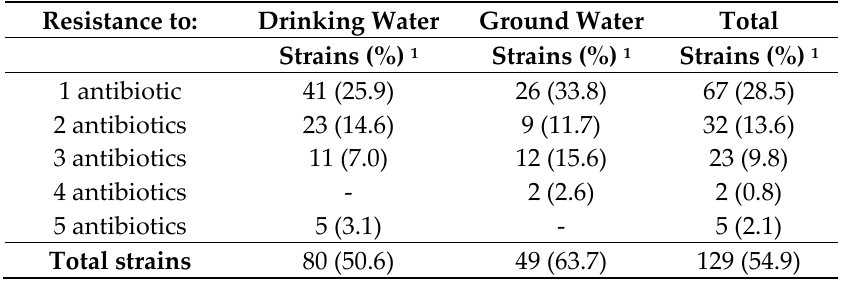
Table 2. Escherichia coli strains resistant to one or more